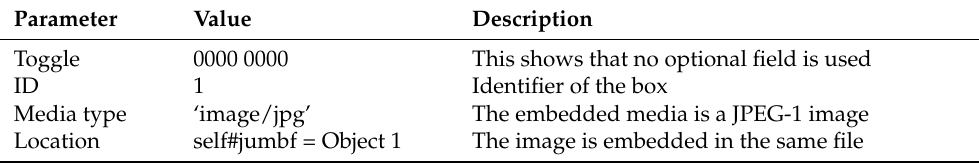
Table A10. Values of the third OBMB parameters for the first example.